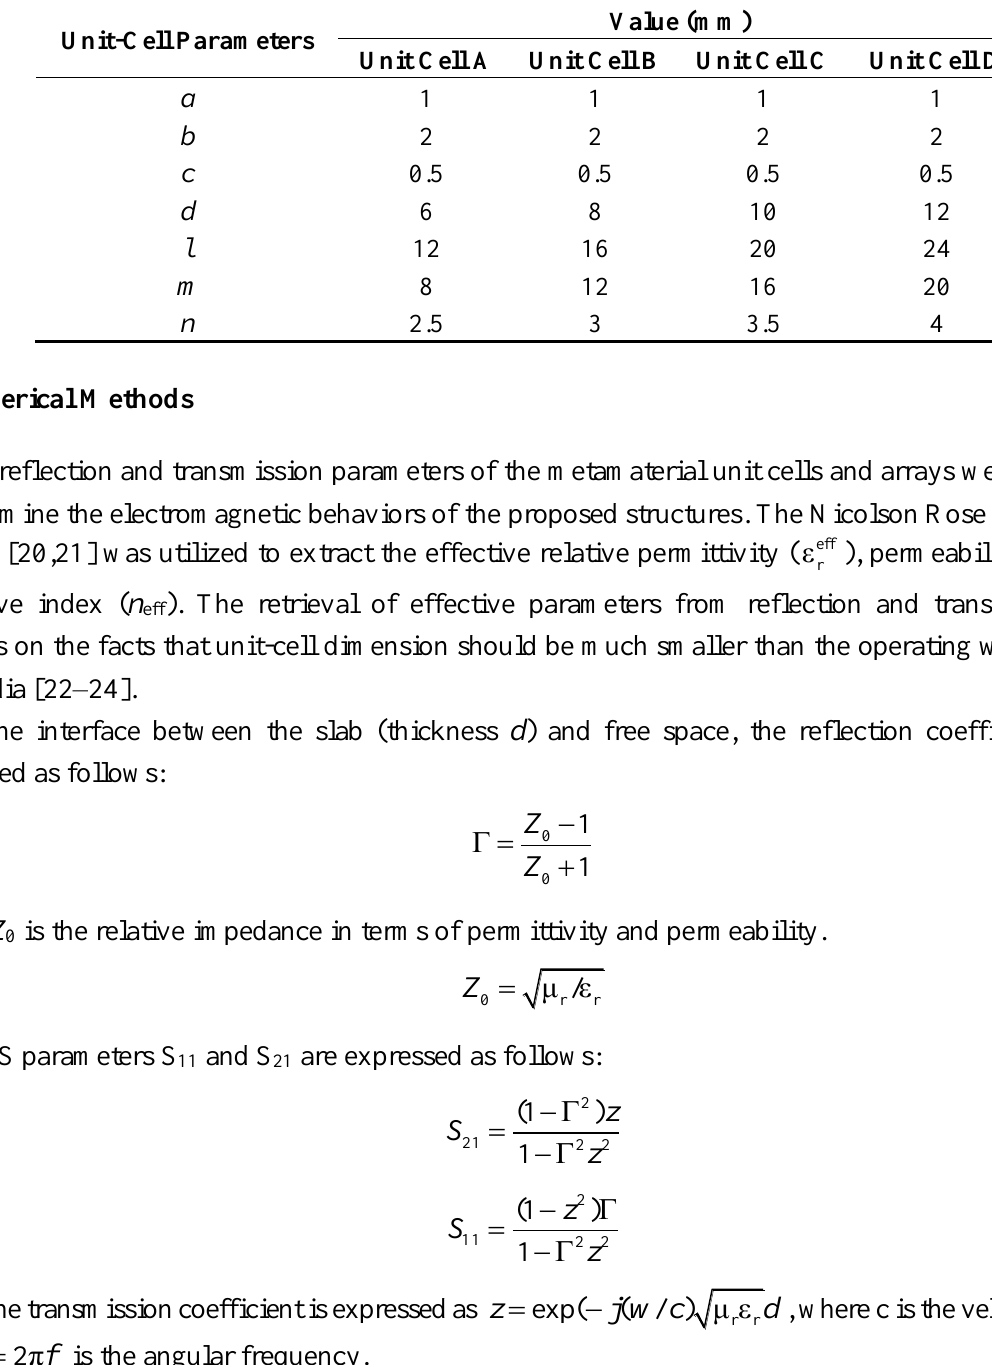
Table 1. Unit-cell design